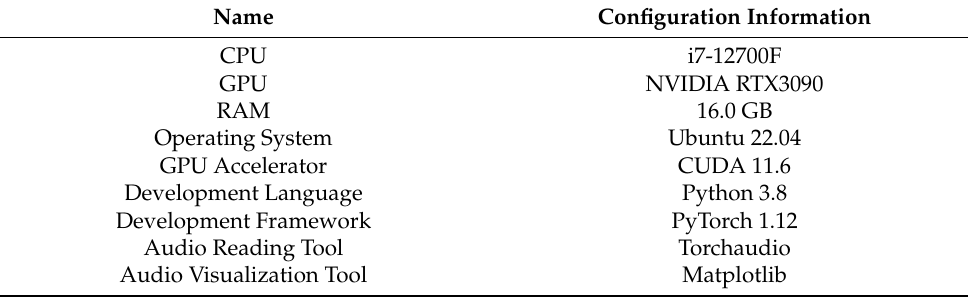
Table 1. Experimental host software and hardware configuration.